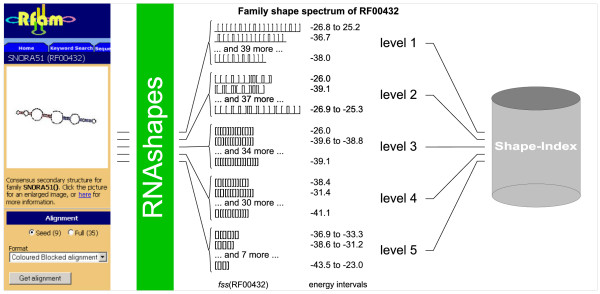
Workflow of a shape index construction. The example demonstrates the process of index construction for the family RF00432. For each of the five shape abstraction levels, an independent shape index has to be computed. For this purpose, every single sequence of each Rfam family (currently 574 families in Rfam 8.0) has to be abstracted with kfamily shapes (kfamily = 2 for the example). This is done by RNAshapes. After the shapes were computed, they are stored in the hash based shape index, where they later serve for the query look-ups. The index is a hierarchically arranged, 3-dimensional search structure – in descending search order of shape-abstraction-level, shape-string and shrep-energy. The example also displays a very characteristic phenomenon: the weaker an abstraction is, the greater is the variance of shapes and the smaller are the family-lists that are associated with these shapes. The last fact is not shown directly, but can be recognized by the increasing energy-interval-size.